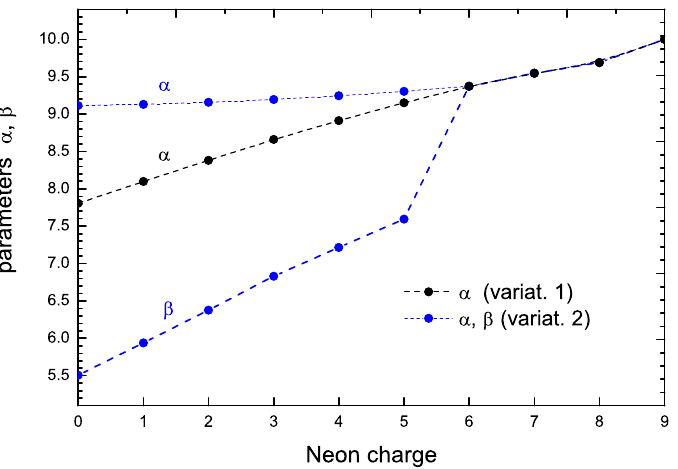
Figure 1. Parameters α and β for Ne n + with charges varying from 0 to 9. The black dots are the results of the one-parameter formulation (V1 case), and the blue dots are those of the two-parameter formulation (V2